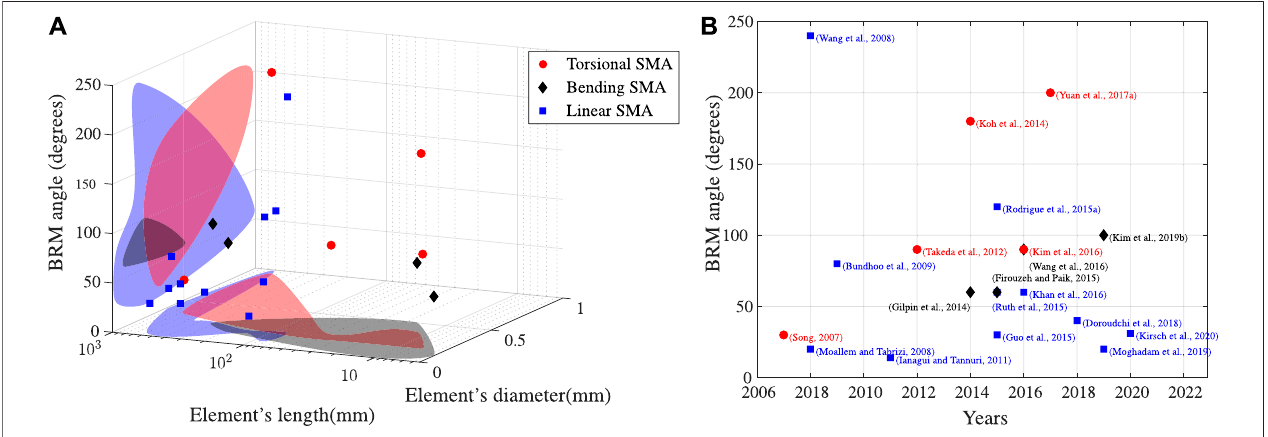
FIGURE 5 | Data report of performance of SMA-based BRM actuators from literature: (A) shows the relationship between the elements dimension and bi- directional motion range of actuators. Colors corresponds to actuator types. Surrounding colors show the boundaries of existing prototypes: For given angle, L-SMA require larger values in terms of SMA lengths; according to the same diameter/thickness of SMAs, T-SMAs offer larger angles than B-SMAs. Publishing-time according to the presented works is provided on the (B) .